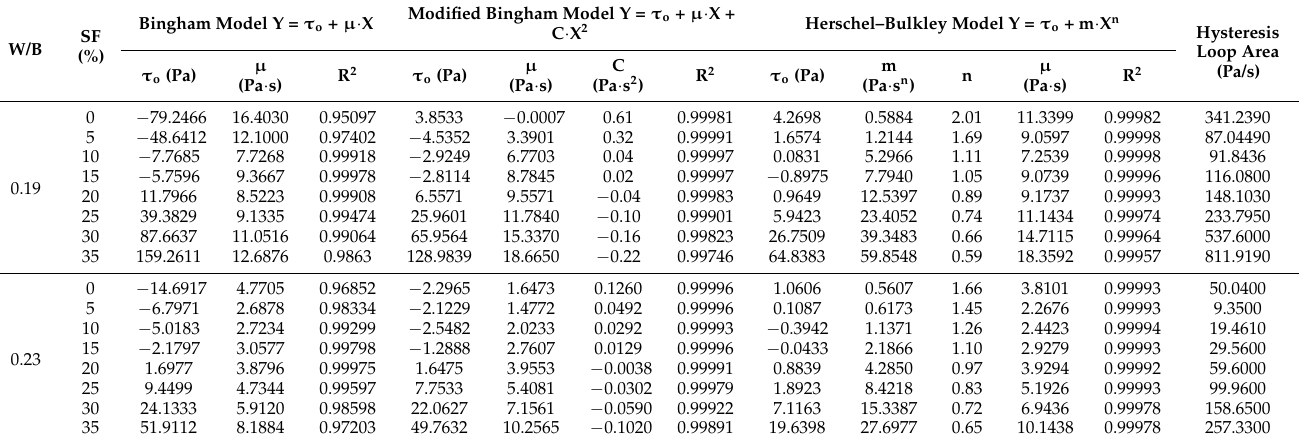
Table 3. Rheological parameters of CSHWMs with different silica fume